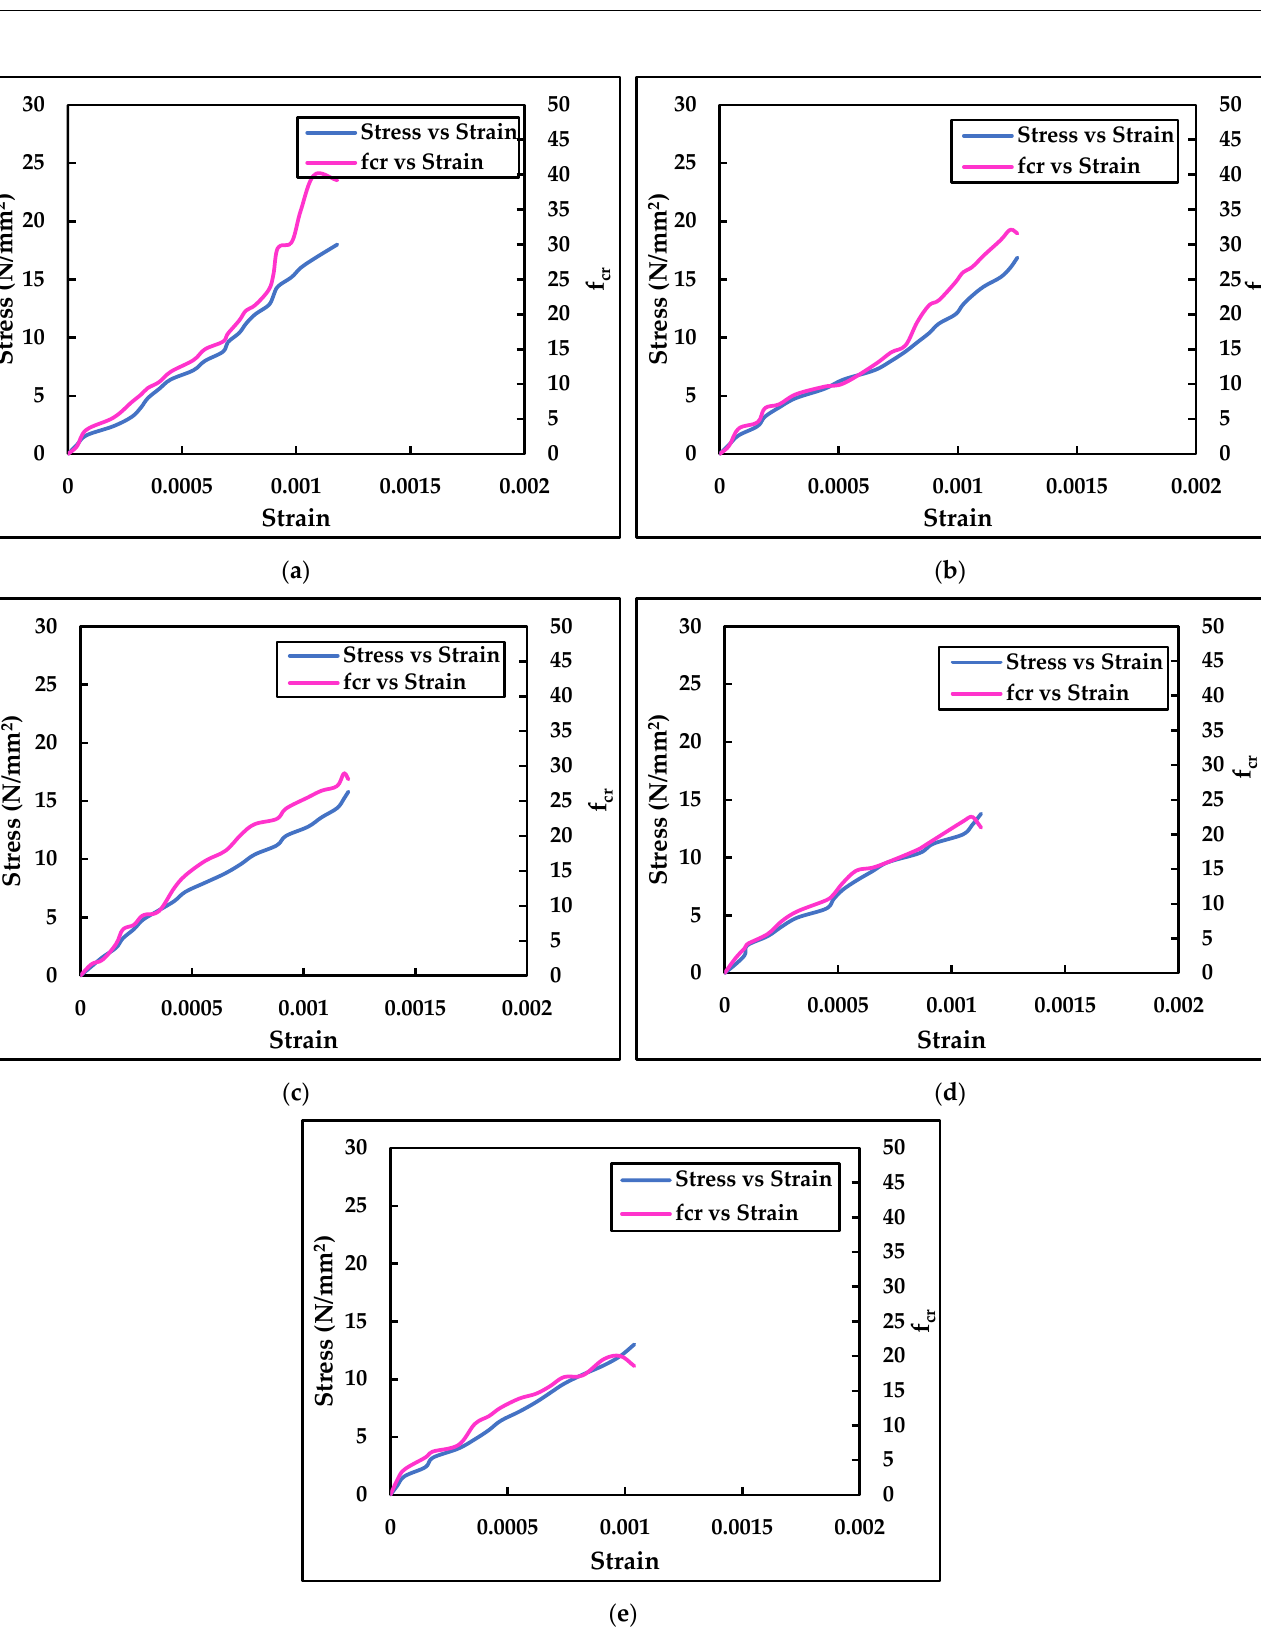
Figure 16. Graphical illustration of stress vs. strain and f cr vs. strain for brass fibre added mortar cube after 28 days of water curing subjected to elevated temperatures. ( a ) Room temperature; ( b ) 200 °C; ( c ) 400 °C; ( d ) 600 °C; ( e ) 800 °C.